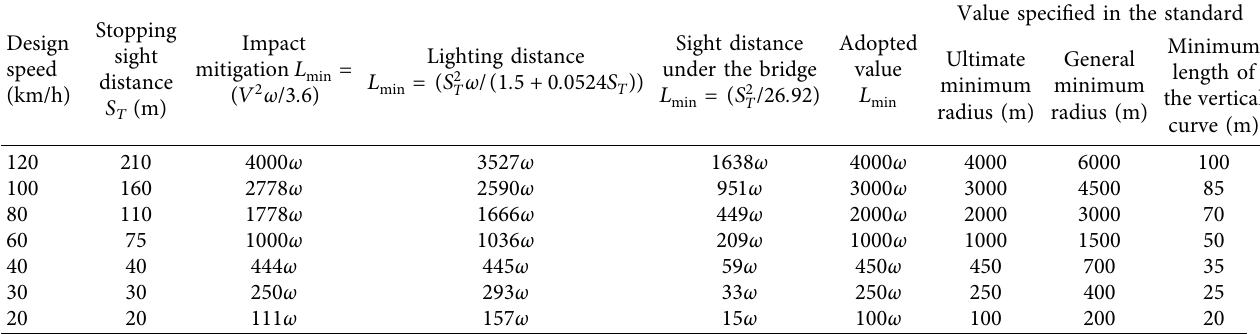
Table 14: The minimum radius of a concave vertical curve of an ordinary highway.